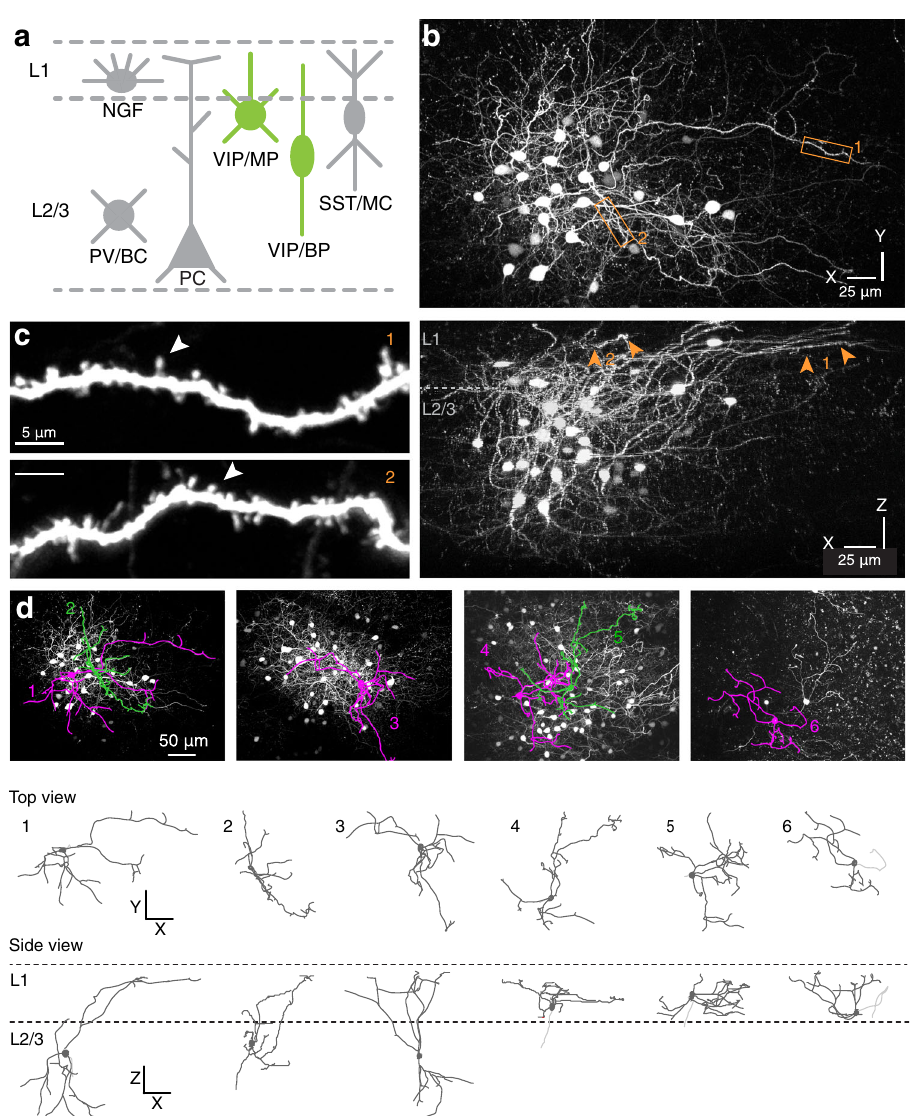
Fig. 1 Fluorescent labeling and imaging of spiny neurons in the VIP-Cre-driver line. a Schematic of the different interneuron subclasses in super fi cial cortical layers. VIP neurons (green) were targeted for labeling. b Top: a maximum intensity projection (top view) of a 2PLSM z-stack spanning the entire injection site harboring GFP-expressing VIP neurons. Bottom: side view of the same injection site, indicating that GFP expression is limited to neurons in super fi cial L1-3. Arrows point to super fi cial spiny dendrites in L1. c High-magni fi cation images of spiny dendritic segments (boxed areas in b ), with arrowheads pointing to examples of spines. d Maximum intensity projections of 2PLSM stacks of GFP-positive VIP neurons and their neurolucida reconstructions. The top and side views show the extent of the dendritic branching patterns and the varying multipolar morphologies of GFP-expressing VIP neurons. Some axons were found to descend towards deeper layers (light